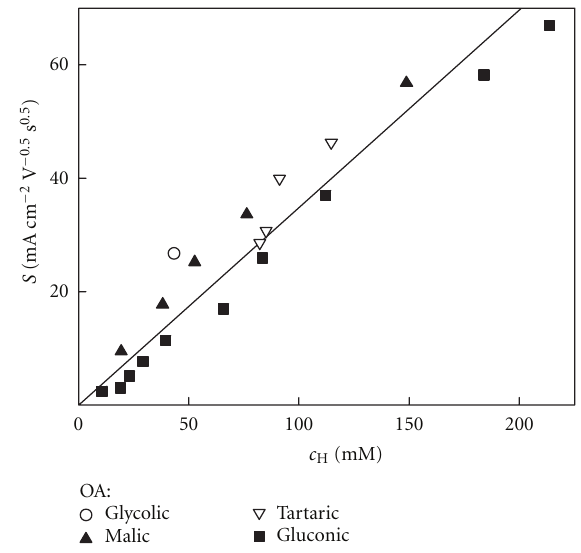
√ ν versus total concentra-